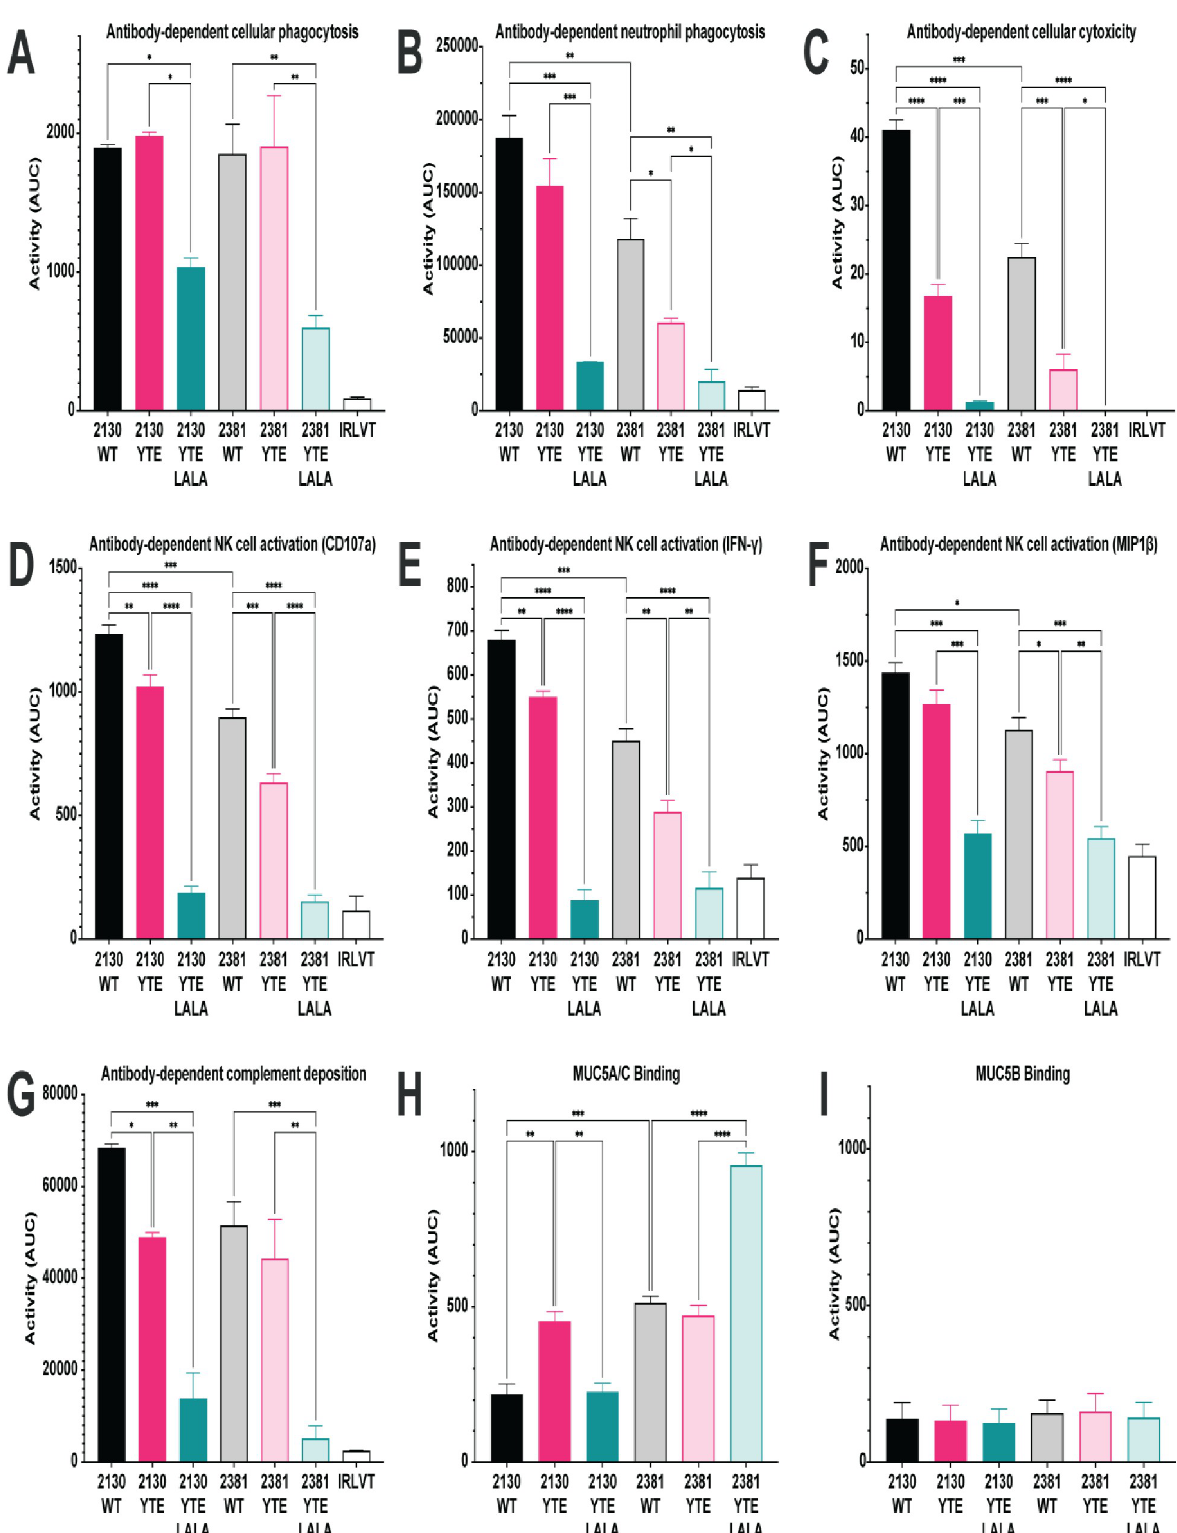
Fig 3. Extra-neutralizing functional activity of the monoclonal antibody variants. The data are presented both as bar graphs representing the overall activity of the monoclonal antibody variants in the indicated functional assays represented as the area under the curve calculated from the